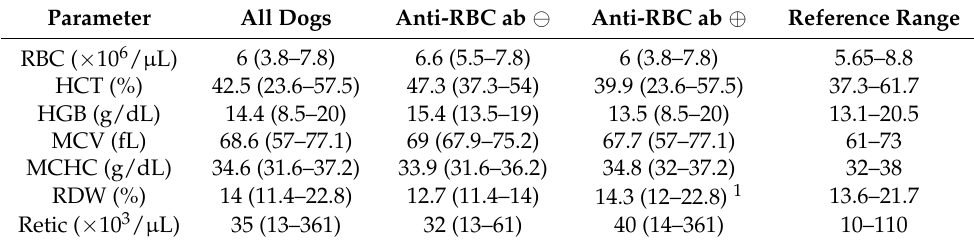
Table 1. Descriptive statistics of erythrocyte parameters in the study